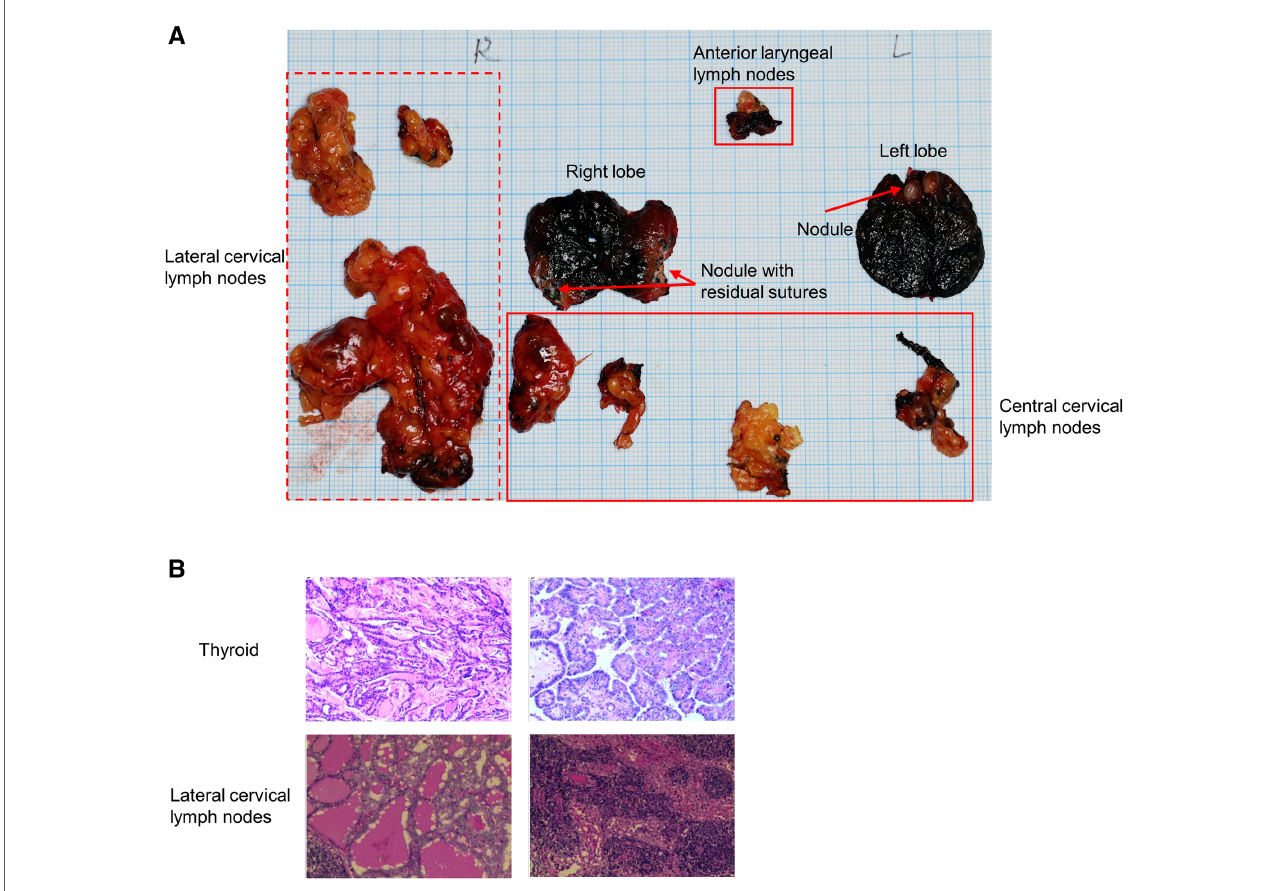
FIGURE 4 Postoperative specimen and pathology. ( A ) Thyroid and lymph nodes specimen. Dotted line box indicates lateral cervical lymph nodes, solid line box indicates central cervical lymph nodes. ( B ) Pathology of thyroid and lymph